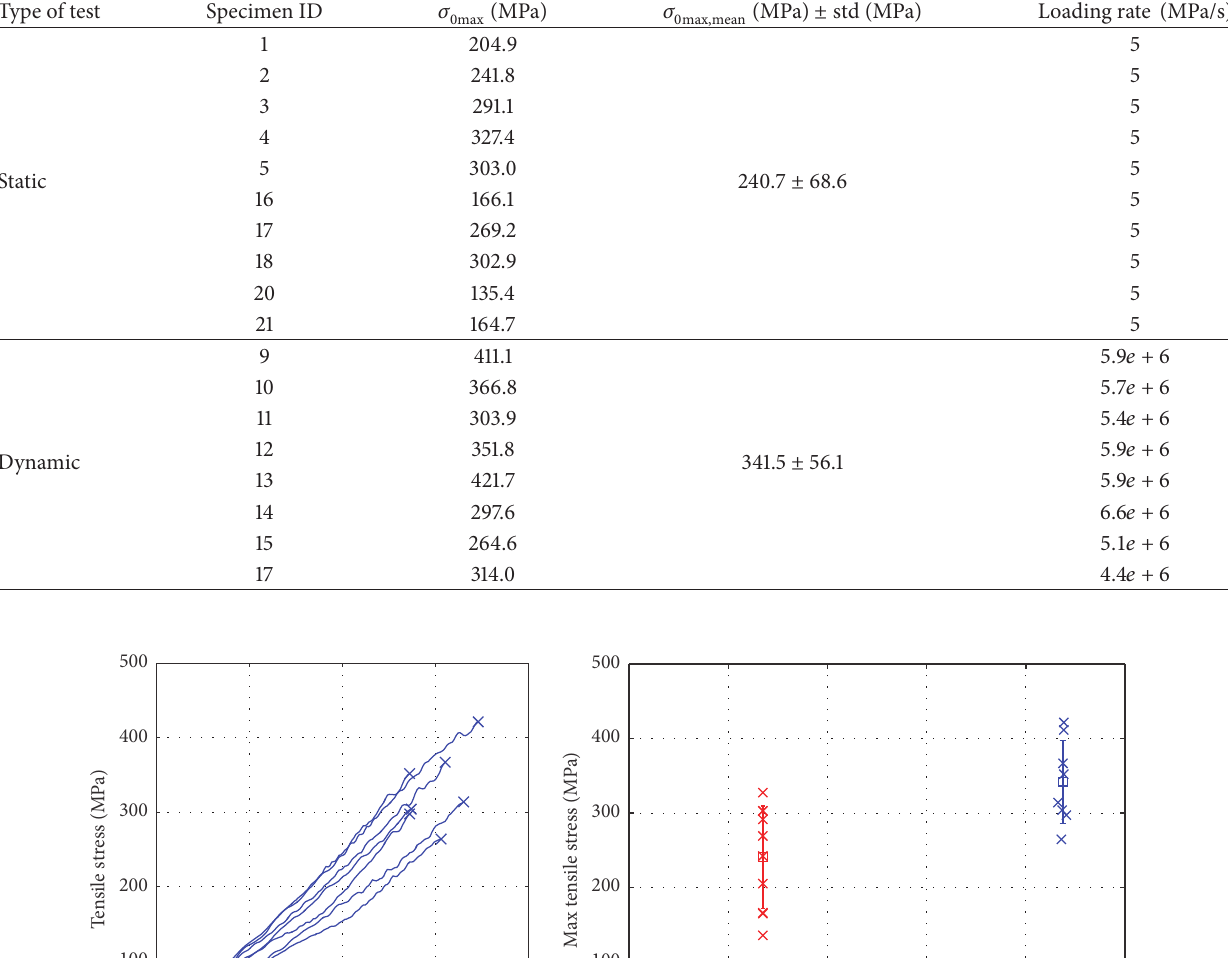
Table 1: Experimental results for Brazilian tests on alumina (Corbit98).